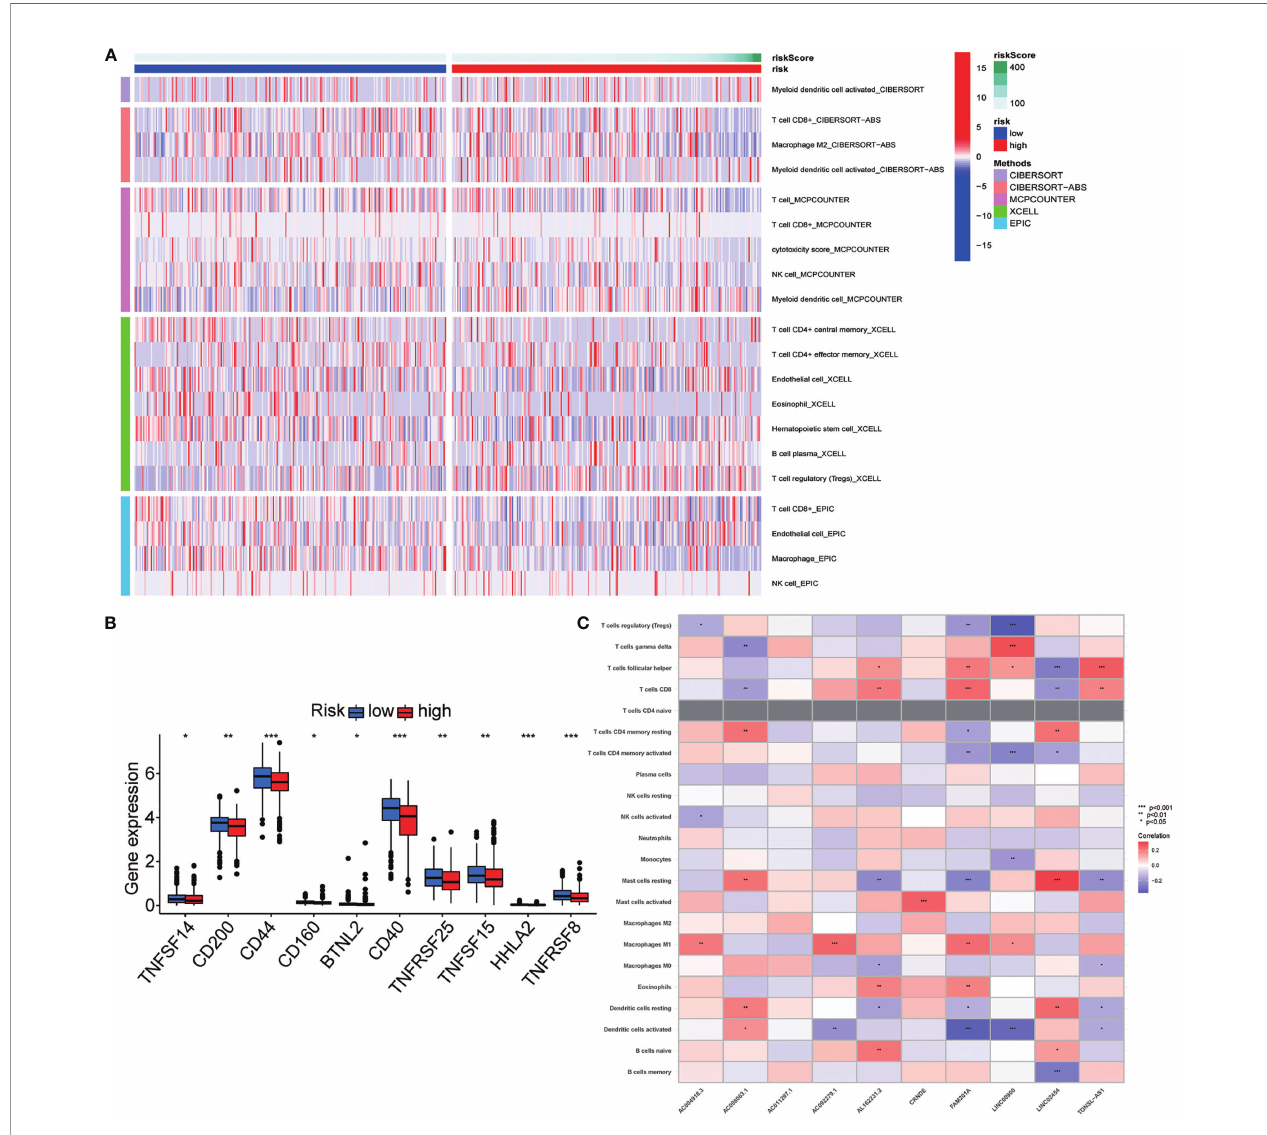
FIGURE 7 | Exploration of the association of the risk strati fi cation with tumor immunity. (A) Immune in fi ltration statuses among high-risk group and low-risk group through TIMER, CIBERSORT, XCELL, QUANTISEQ, MCPcounter, EPIC, and CIBERSORT database. (B) Differential expression checkpoint gene in papillary thyroid carcinoma (PTC) sample of high-risk and low-risk patients. (C) Correlation between the long noncoding RNA (lncRNA) involved in the risk strati fi cation and immune cell in fi ltration. Symbols *, **, *** means that p-value <0.05, <0.01 and <0.001,